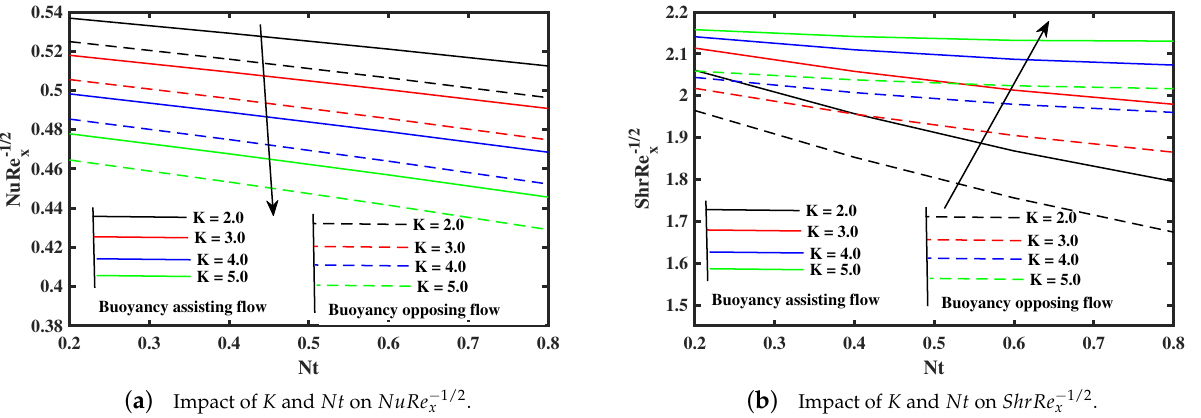
Figure 12. Fluctuation of NuRe − 1/2 x and ShrRe − 1/2 x against material parameter ( K ) and thermophoresis ( Nt ).